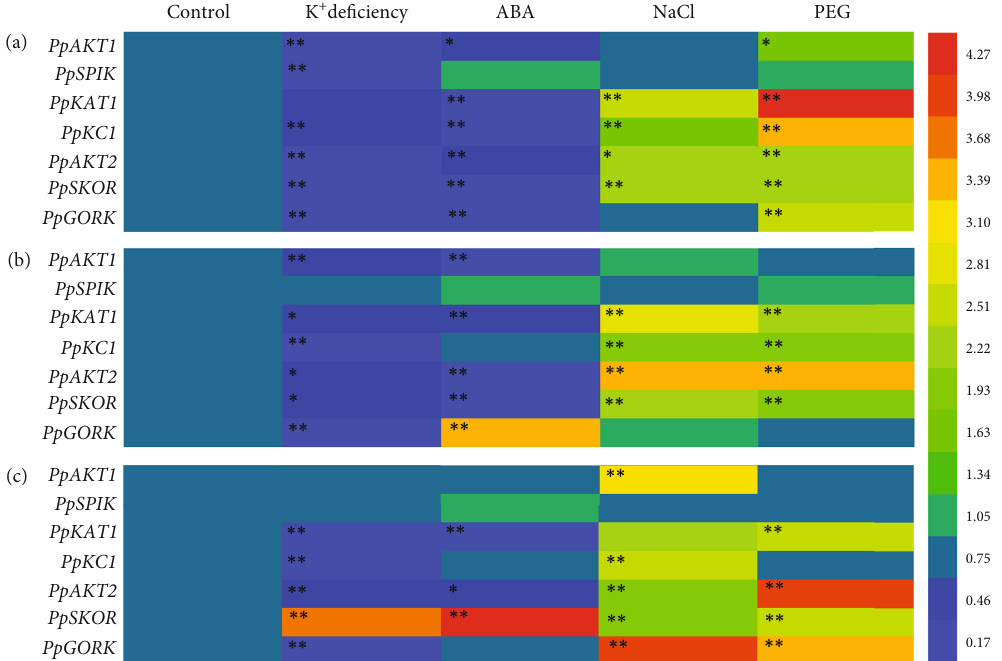
Figure 5: Heat map analysis of the peach shaker K + channel genes in response to K + depletion, ABA, NaCl, and PEG stresses in seedlings. Asterisks indicate statistical di ff erences between plants under control and stress treatment ( ∗ P < 0 : 05 and ∗∗ P < 0 : 01 ; independent samples t